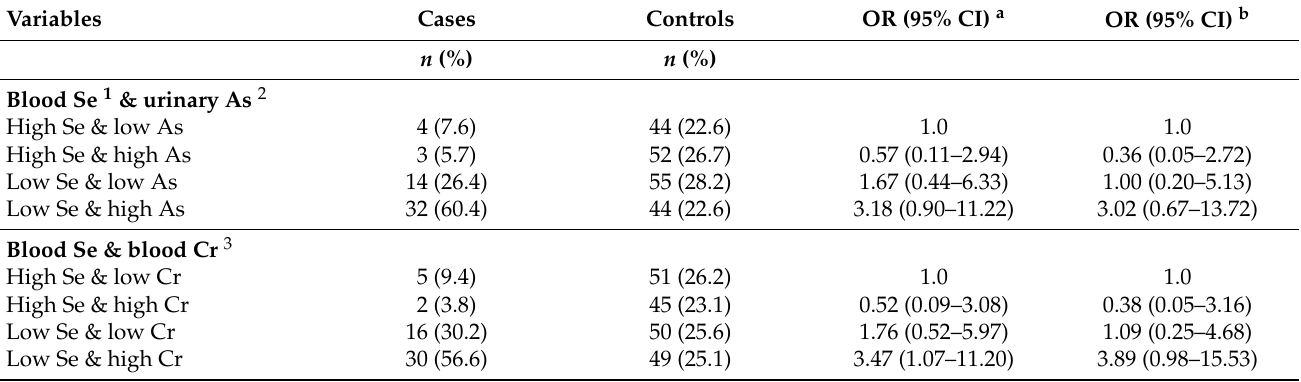
Table 3. Odds ratios (ORs) and 95% confidence intervals (CIs) for the association between